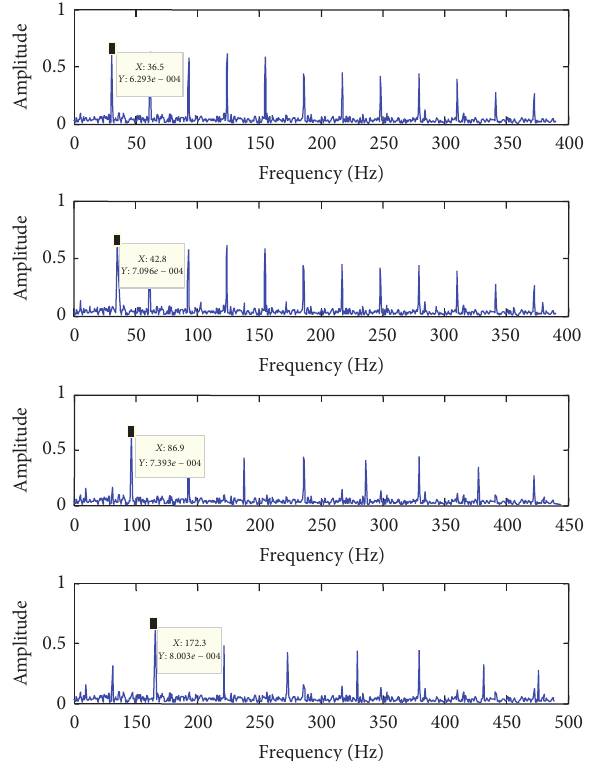
Figure 8: FFT analysis of RD at 2000 RPM, 2500 RPM, 5000 RPM, and